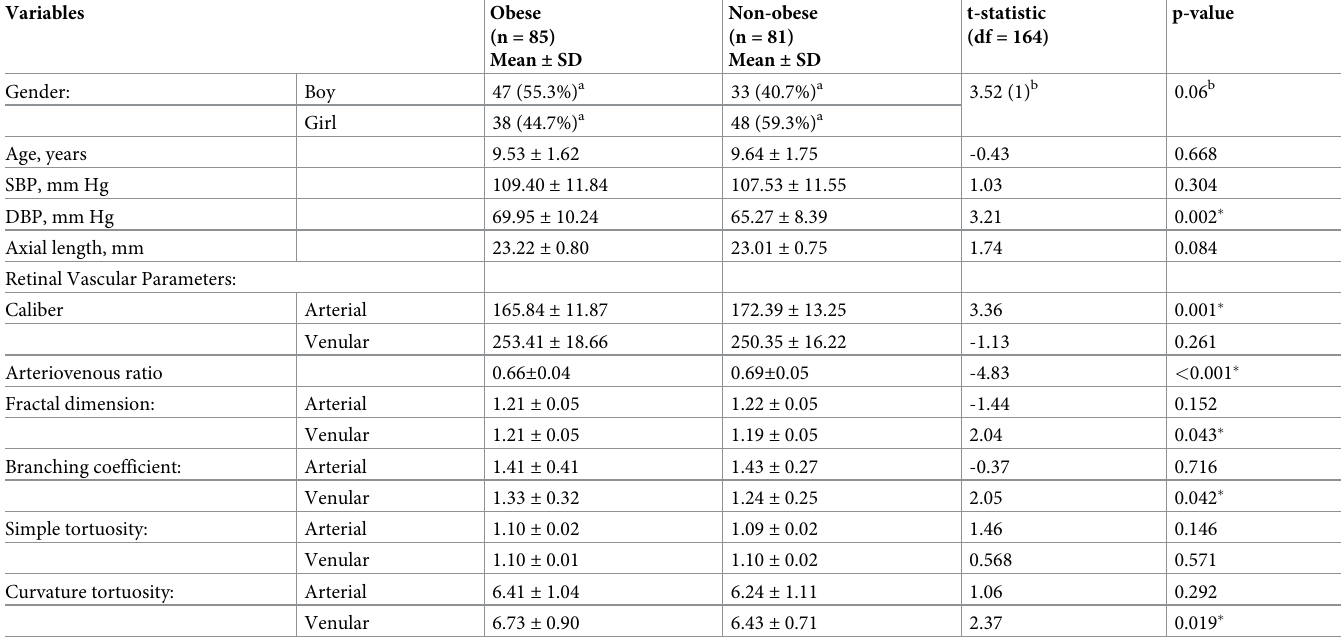
Table 1. Characteristics of participants in obese and non-obese